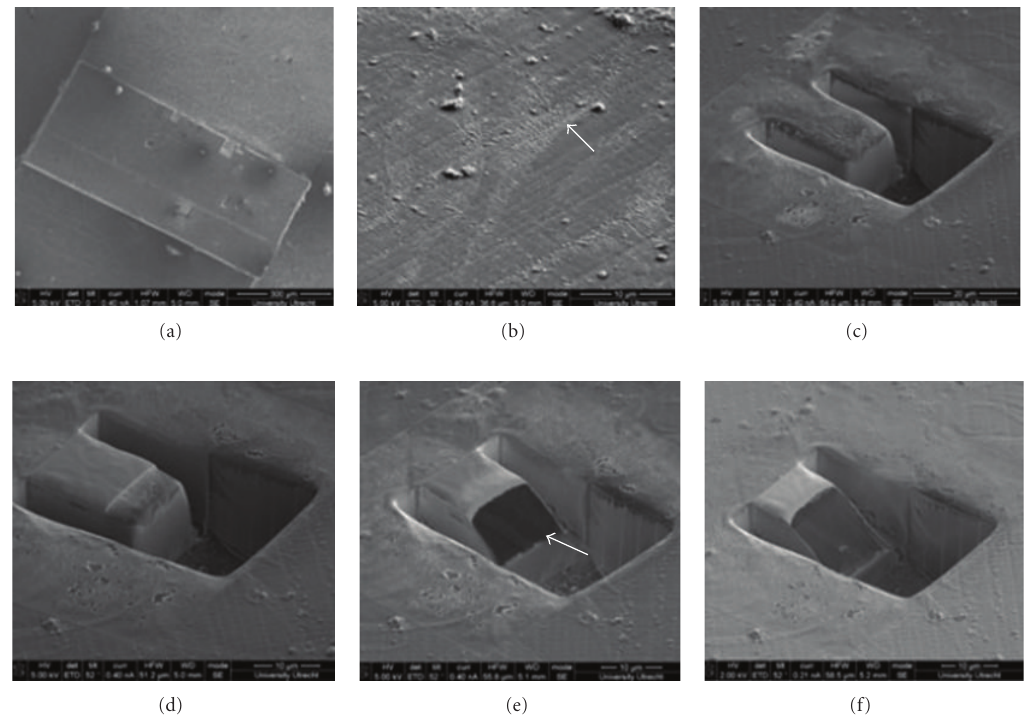
Figure 1: The slice and view geometry used by De Winter et al. The U-Shaped trench around the surface of interest improved contrast uniformity and reduced shadowing e ff ects, reproduced with permission from [1].